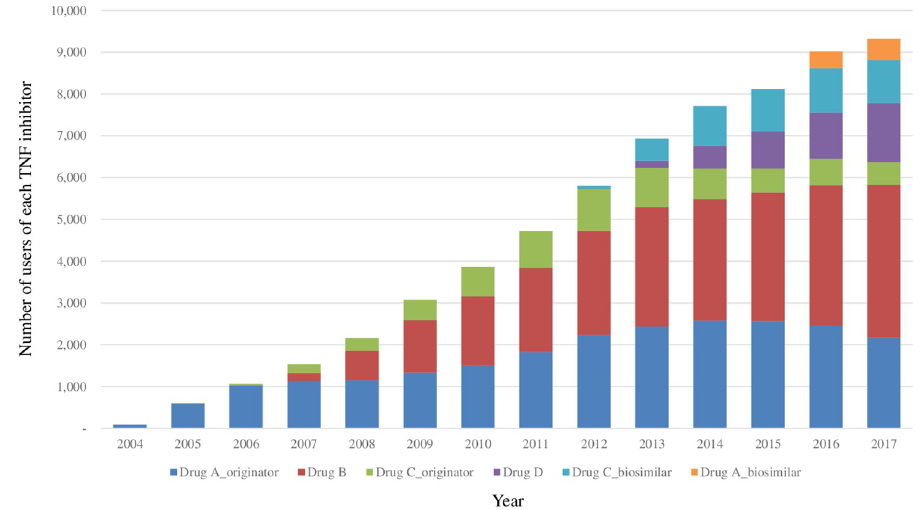
Fig 2. Use of each TNF inhibitor in patients with RA or AS since the approval of TNF inhibitors: Numbers of users of each TNF inhibitor with RA or AS since the approval of TNF inhibitors.